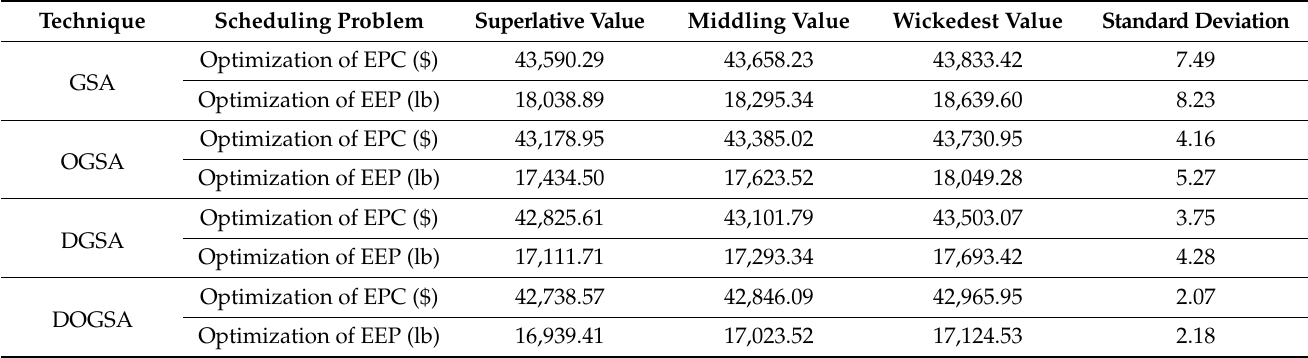
Table 12. Test system-II Statistical analysis with various